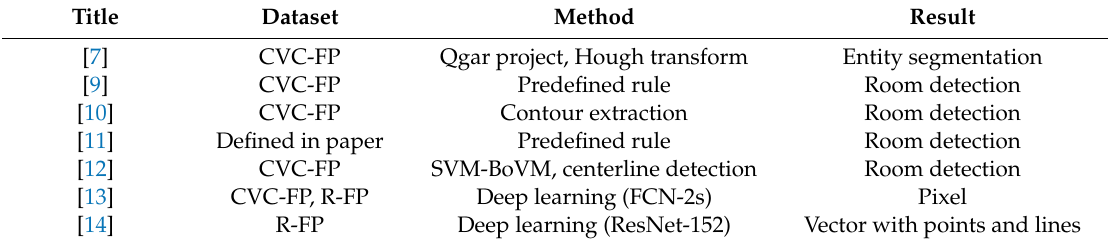
Table 1. Summary of the datasets, methods, and results of selected previous